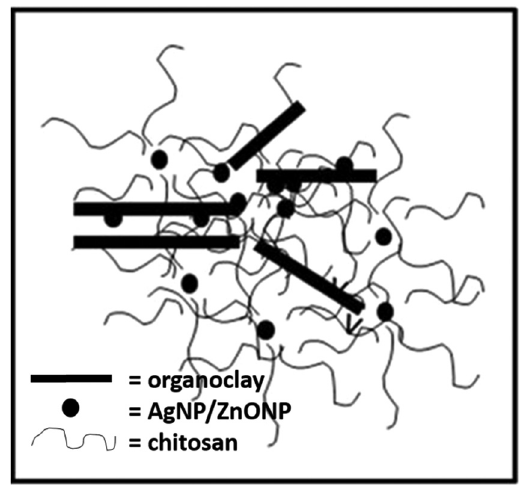
Figure 5: The illustration fi gure of the interaction of organoclay, AgNPs, and ZnONPs modi fi ed CS.